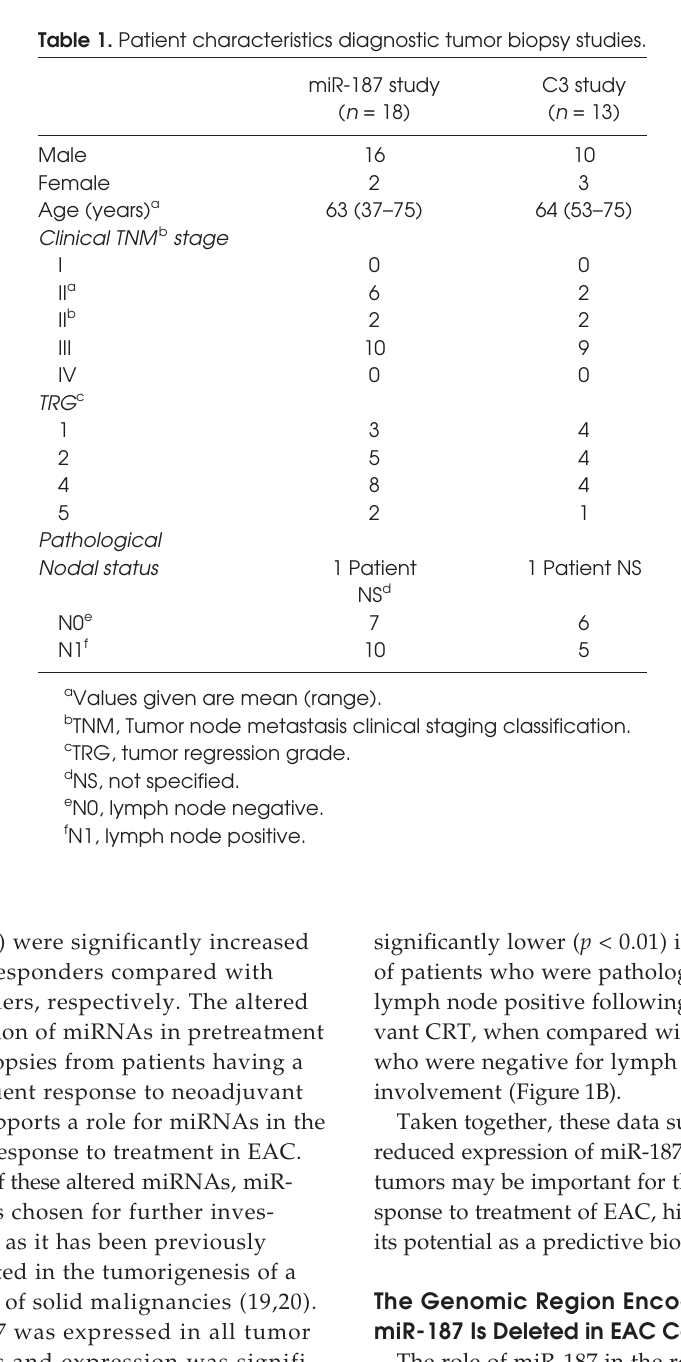
Table 1. Patient characteristics diagnostic tumor biopsy studies. miR-187 study